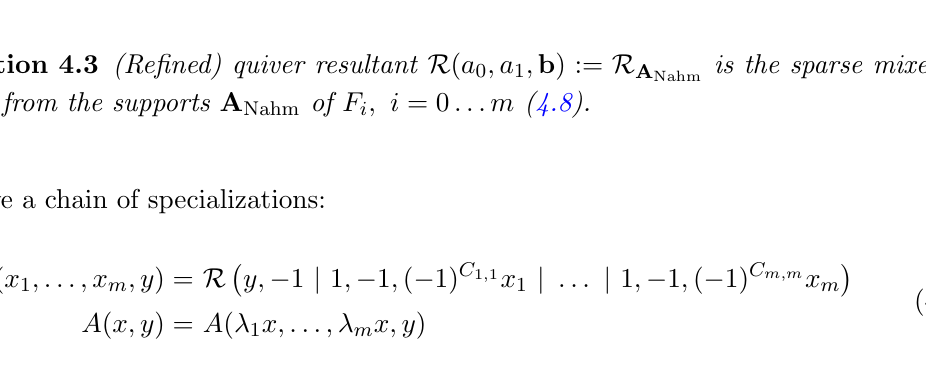
Figure 3 . The Minkowski sum of three intervals (generators) Q 0 ; Q 1 ; Q 2 is a hexagon, each bound- ary face of which corresponds to one of its